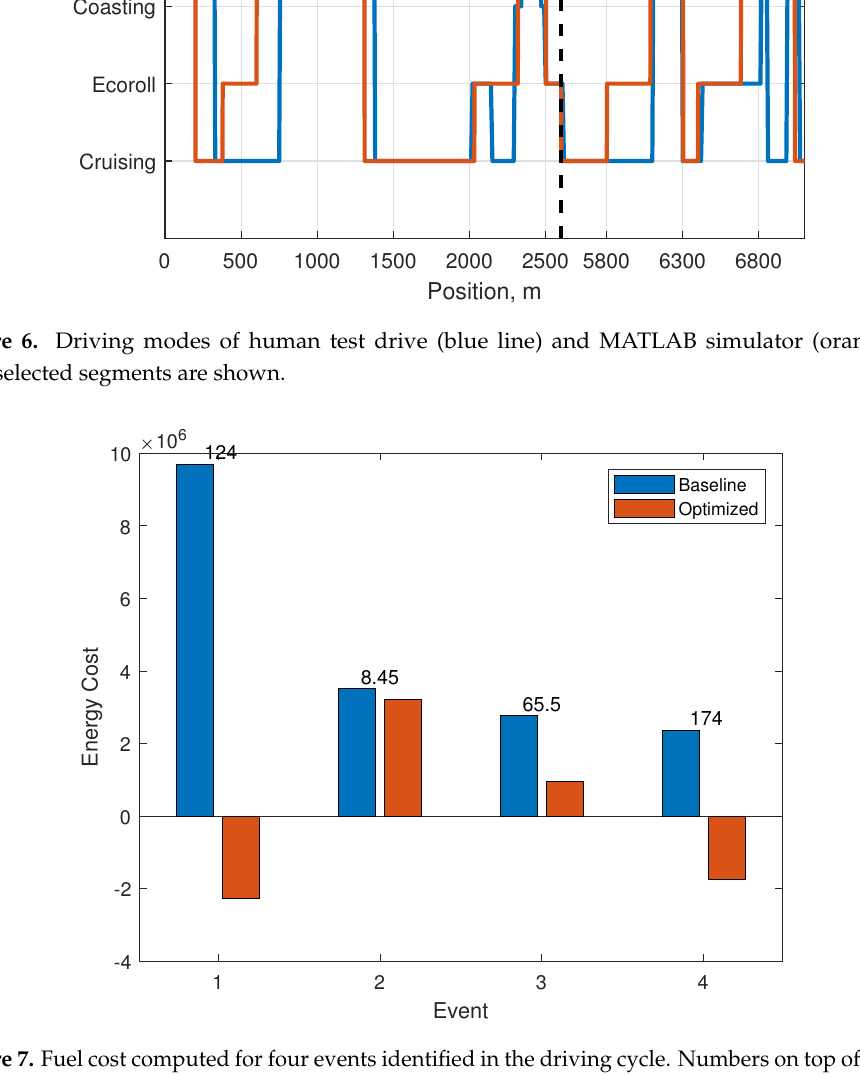
Figure 7. Fuel cost computed for four events identified in the driving cycle. Numbers on top of each bar are the percentages of fuel improvement using our optimization algorithm. Negative values indicate engine braking mode usage for battery